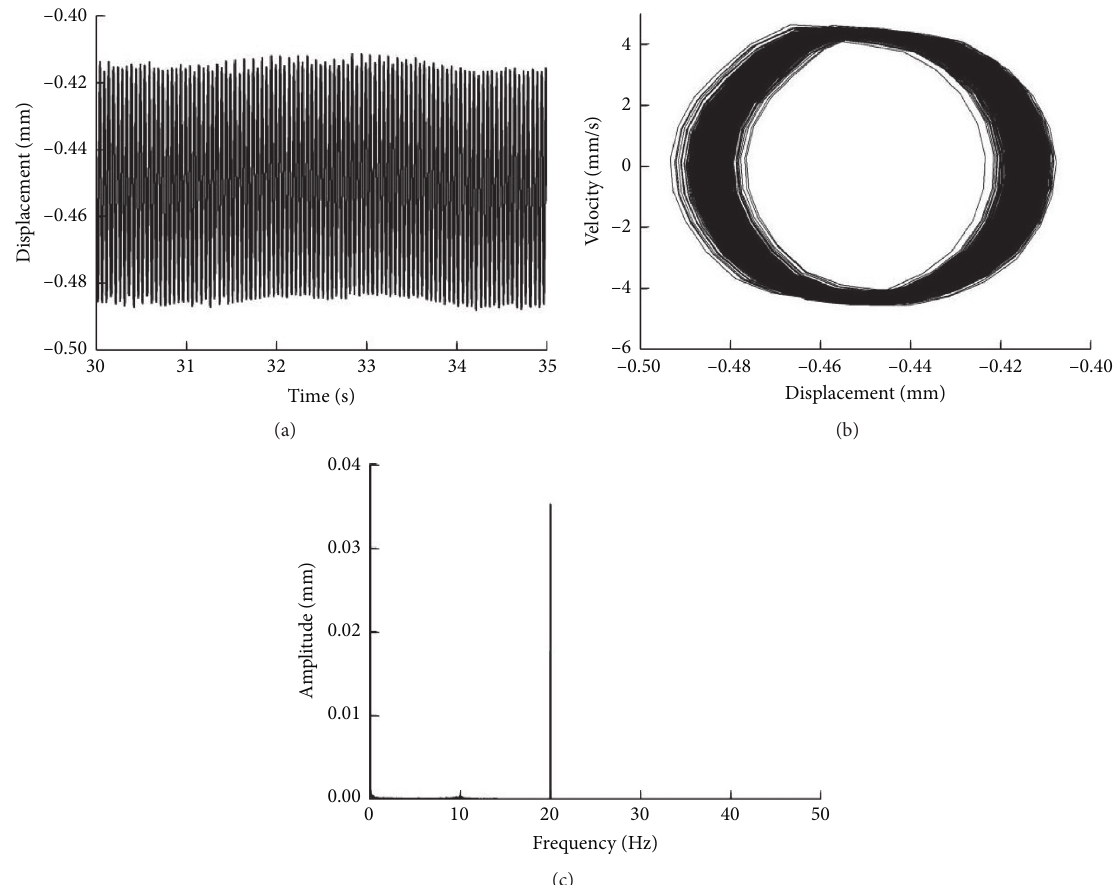
Figure 15: Quasiperiodic motion of the structure A is obtained for the external excitation frequency Ω � 20 . 8 Hz: (a) waveform; (b) phase portrait; (c) amplitude